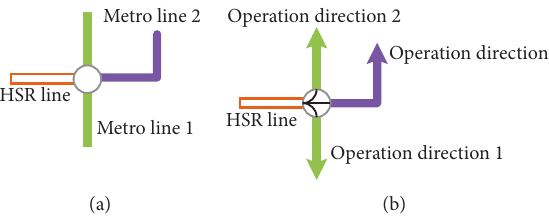
Figure 1: Illustrative network of HSR and metro